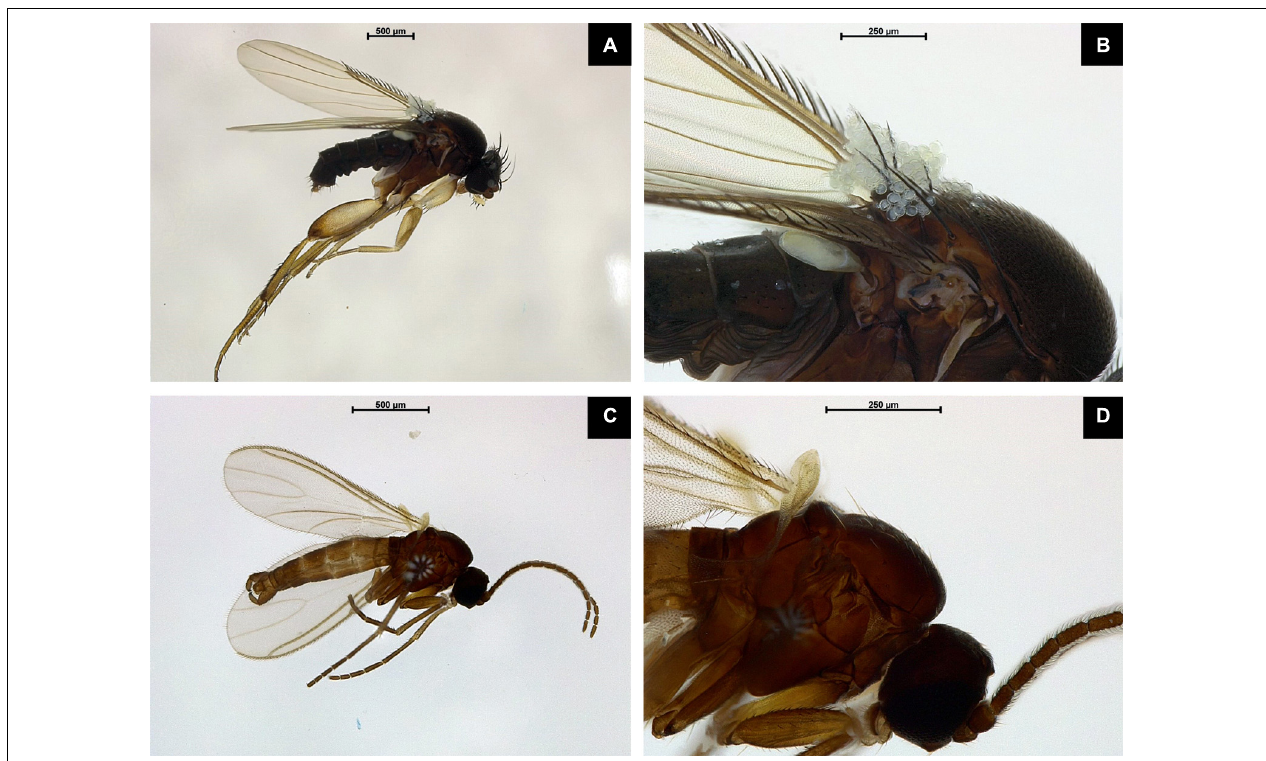
FIGURE 3 | Two specimens of the two most frequent Diptera families visiting flowers of Aristolochia microstoma : (A) a pollinating female Megaselia sp. (Phoridae) carrying pollen on its thorax (B) ; and (C) a male of an unidentified species of Sciaridae not carrying pollen (D)